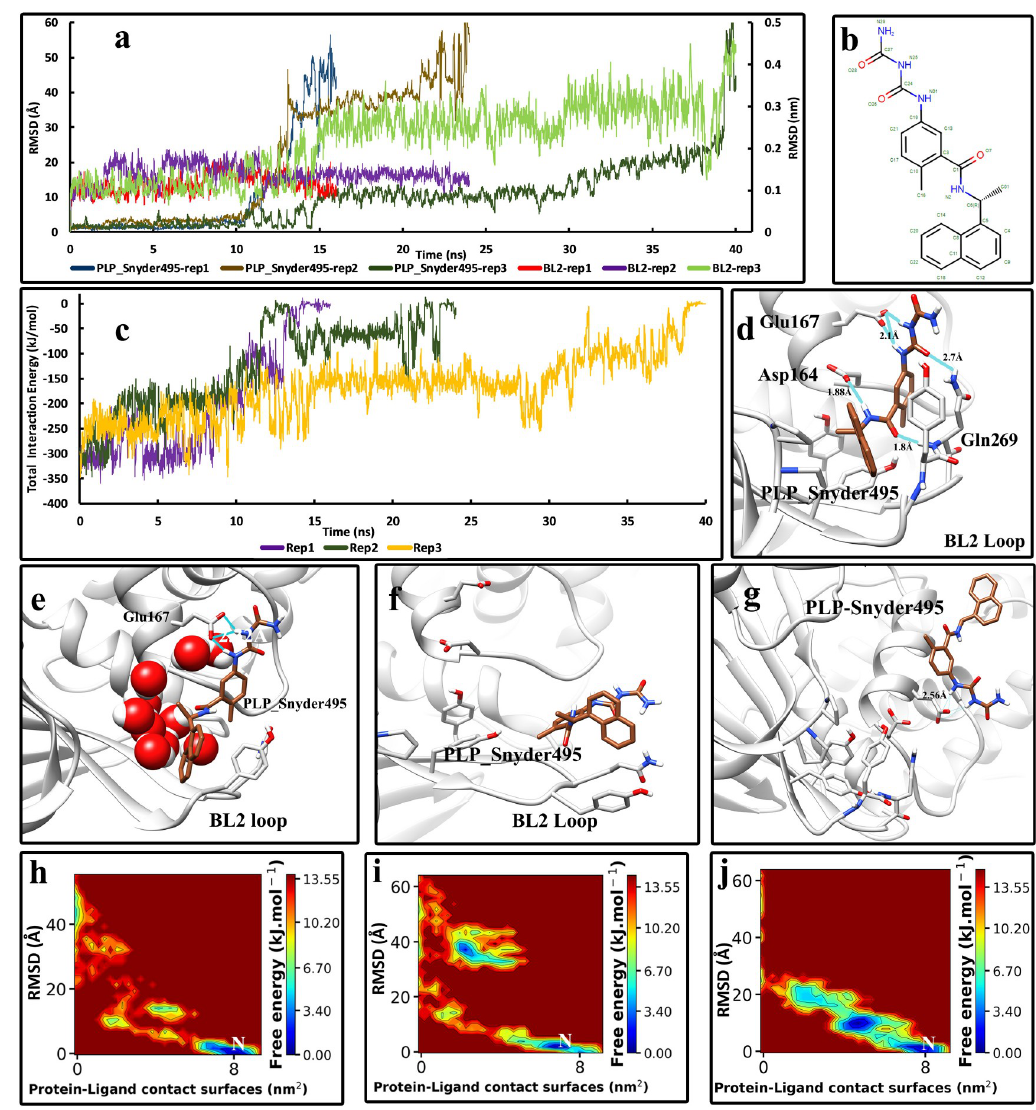
Fig 4. The details of the unbinding pathway of PLP_Snyder495 from SARS-CoV-2 Plpro in three series of replicas. (A) The RMSD values of the inhibitor in three replicas (Displayed in Å ) and the backbone RMSD values of residues of the BL2 loop in three replicas (Displayed in nm) throughout the simulations. (B) The 2D structure of PLP_Snyder495 was obtained from PDB. (C) The Total interaction Energies of the protein-ligand complexes throughout the simulations. (D) The bound state of the PLP_Snyder495 in the crystallographic (native) conformation and the interactions with the residues of the binding pocket (frame at 0 ns). (E) An intermediate state of PLP_Snyder495 in the unbinding pathway where the inhibitor gradually lifted up and out of the binding pocket and made stronger hydrogen bonds with the Glu167 (1 st replica, frame in 12 ns). (F) Another intermediate state where the BL2 loop is entirely flat and the inhibitor is stuck to the residues on the tip of the loop (Tyr268 and the Gln269) (3 rd replica, frame in 25 ns). (G) The unbound state of the inhibitor is entirely free and solvated in the simulation box. (H) The free energy landscape (FEL) representation of the unbinding pathway of the PLP_Snyder495, replica No 1. (I) The free energy landscape (FEL) representation of the unbinding pathway of the PLP_Snyder495, replica No 2. (J) The free energy landscape (FEL) representation of the unbinding pathway of the PLP_Snyder495, replica No 3. Letter “N” indicates the native crystallographic